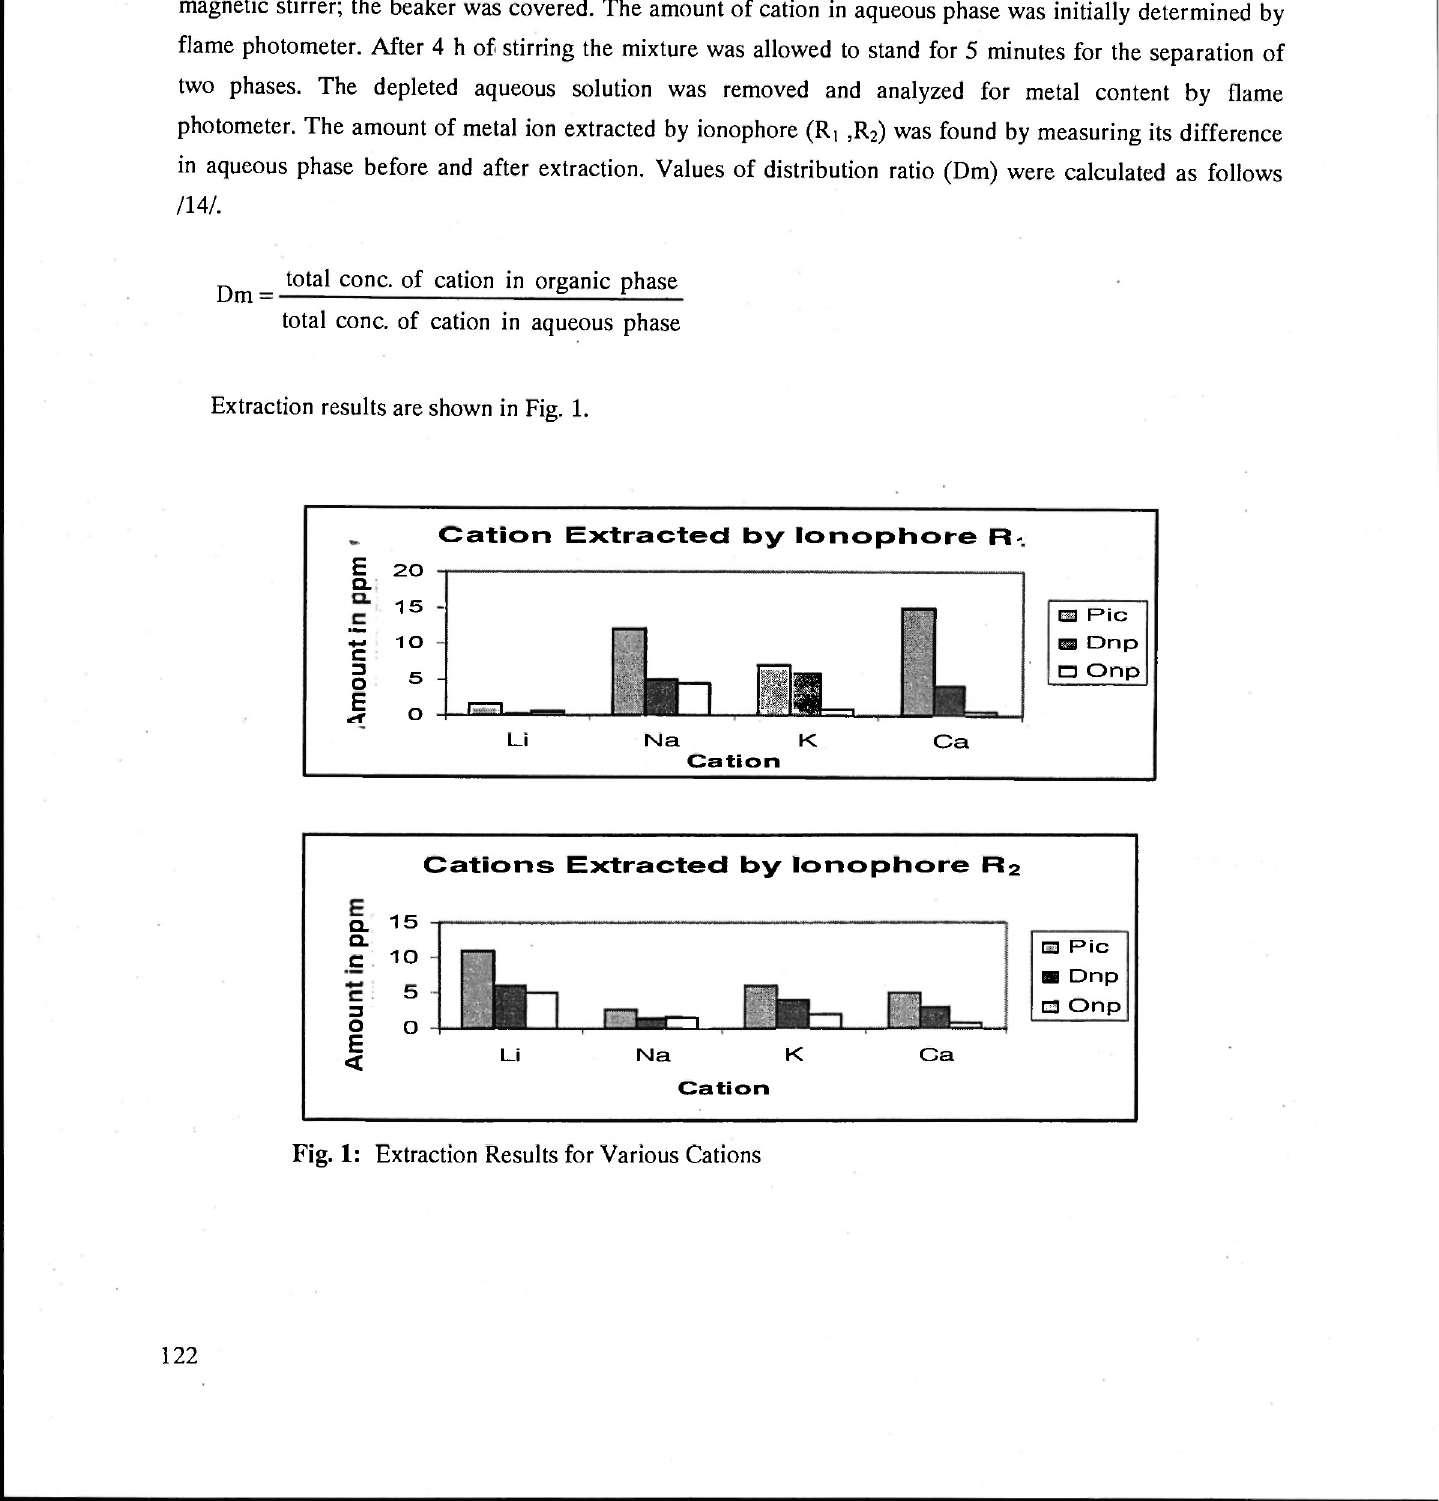
Fig. 1: Extraction Results for Various